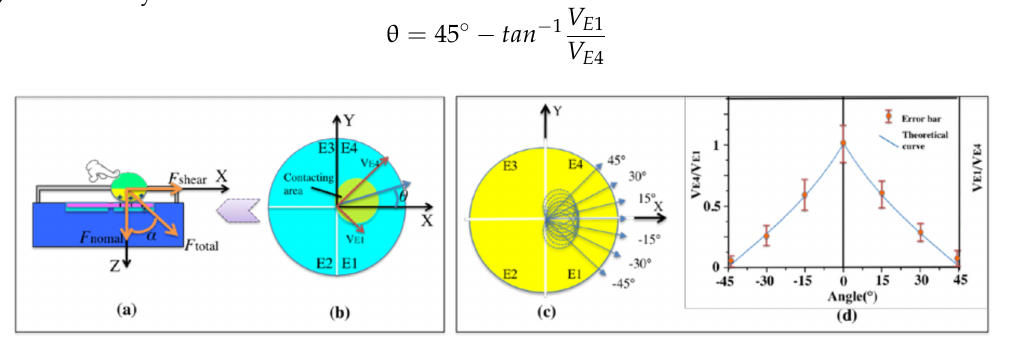
Figure 5. ( a ) Analysis of force component acting on the self-powered sensor. ( b ) The structure form with four electrodes and working mechanism for shear force detecting. ( c ) Repetitive motion of finger in different directions from − 45 ◦ to 45 ◦ , increasing in a step of 15 ◦ . ( d ) Relationship between the measurement curve with error bars of V E 1 / V E 4 (0–45 ◦ ), V E 4 / V E 1 ( − 45 ◦ − 0), and the theoretical